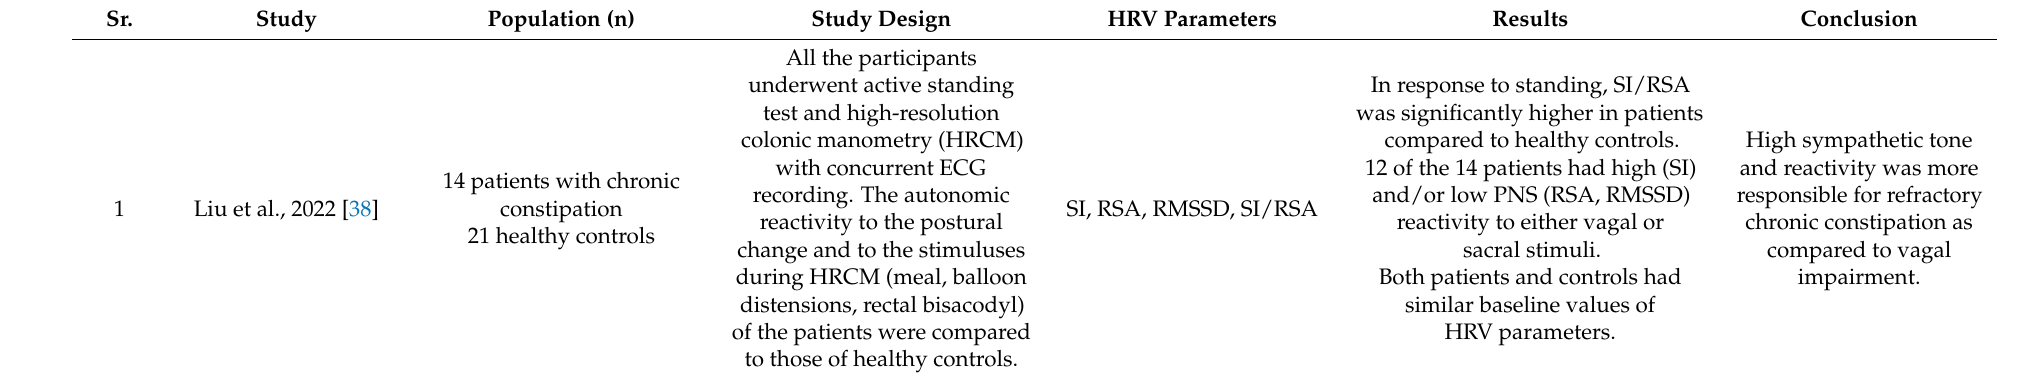
Table 5. Summary of studies: Autonomic Nervous System and Constipation.